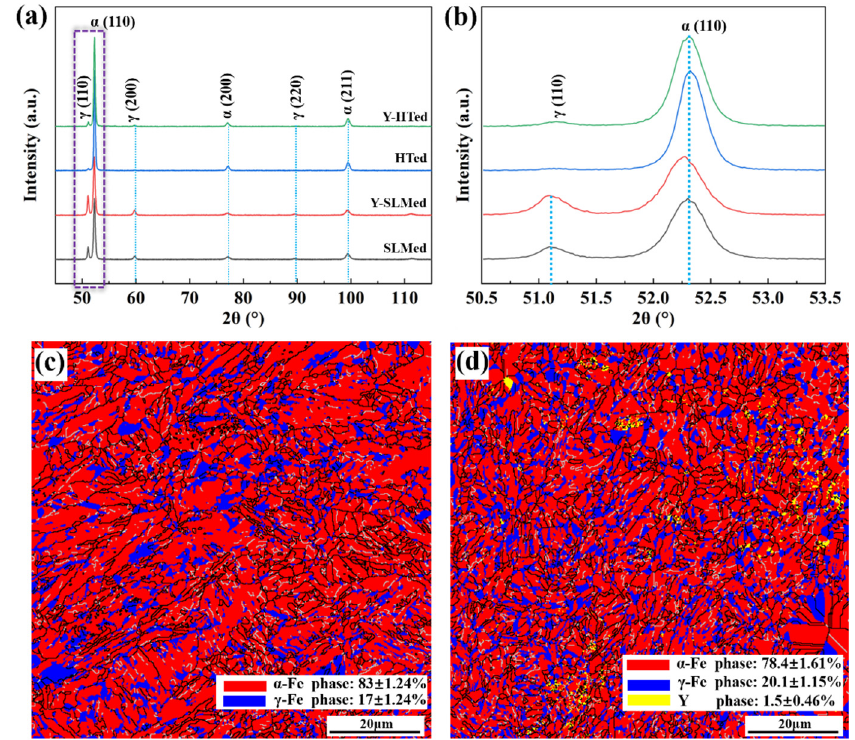
Figure 5. ( a ) XRD patterns of SLM-formed parts with Y and without Y; ( b ) local XRD pattern in ( a ); ( c ) EBSD phase distribution diagram of yttrium-free formed parts; ( d ) EBSD phase distribution diagram of yttrium-containing formed parts.